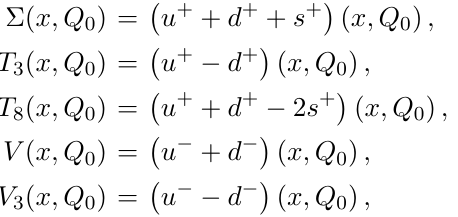
Figure 2 . The leptonic rapidity distributions for W (cid:0) boson production at center-of-mass frame. Our MCFM -based calculation is compared with the theory predictions provided in [64] both as absolute cross-sections (upper) and as ratios to the experimental data (lower panel). In both cases the CT14 NLO proton PDF set is adopted and nuclear corrections are